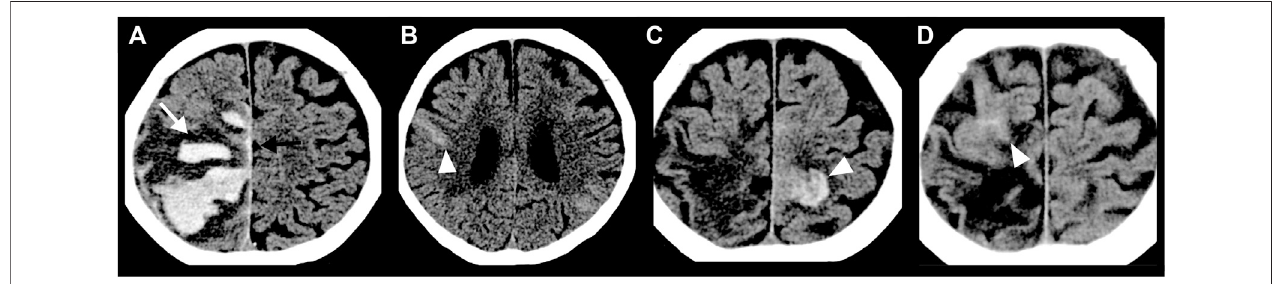
FIGURE 1 | Head CT images of an 84-year-old woman with CAA showing repeated non-traumatic intracranial hemorrhage over four months. (A) ICH presenting fi nger-like projections (white arrow) with SAH extension (black arrow). (B) Acute convexity SAH (arrowhead) at two months later than A . (C) Acute convexity SAH (arrowhead) at three months later than A . (D) Acute convexity SAH (arrowhead) at four months later than A